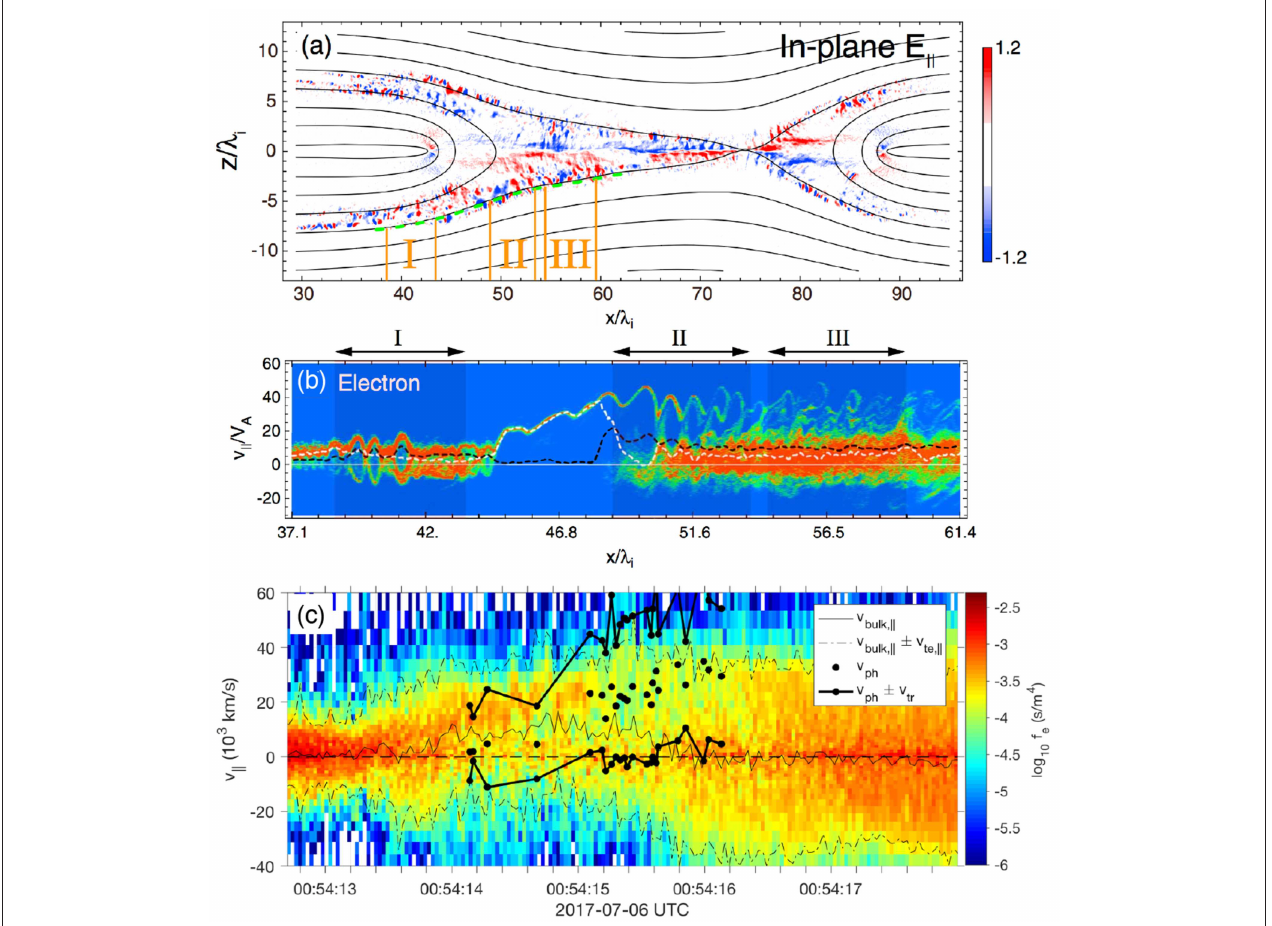
FIGURE 5 | Electron phase space holes observed at the separatrix regions of magnetic reconnection. The electrons are accelerated toward the X line through a potential drop. The streaming electrons lead to instabilities and electron trapping. (a) Parallel electric fields and (b) reduced electron phase space density along the green dashed line in panel a of a numerical simulation of symmetric magnetic reconnection. The white dashed line shows the bulk velocity while the black line shows the thermal speed. Adapted from Fujimoto (2014). (c) MMS observations from a separatrix region in the magnetotail. The colormap shows the reduced electron VDF in which we can see how the lobe electrons become accelerated. The black dots show the speeds of individual ESWs, while the bounding black lines show the range of velocities in which the ESWs and particle distribution can interact